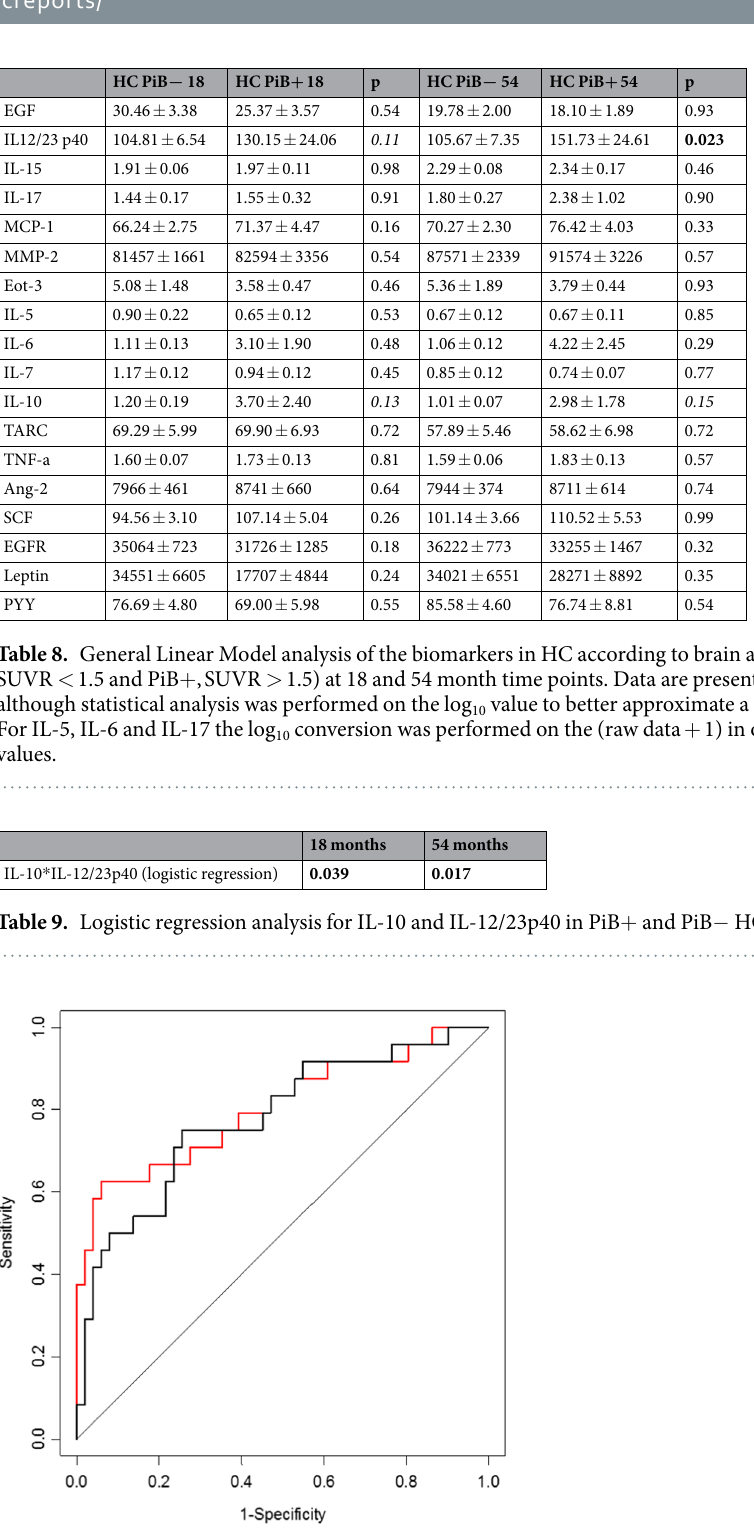
Figure 1. ROC analysis performed at 54 months. The black line represent the base model (age + sex + APOE ε 4), while the red line represents the base model + log(IL-10 *